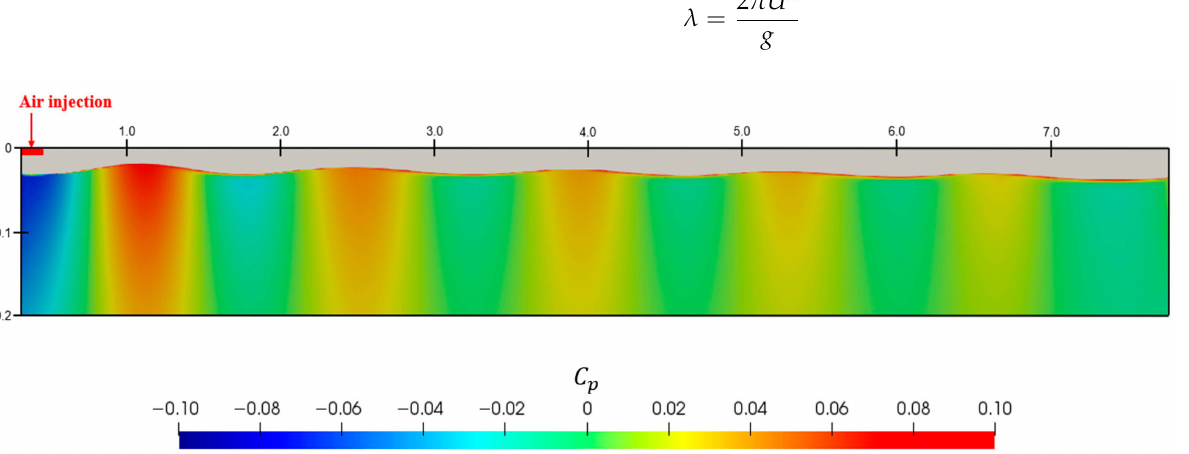
Figure 11. Pressure coefficient contours below the air layer.